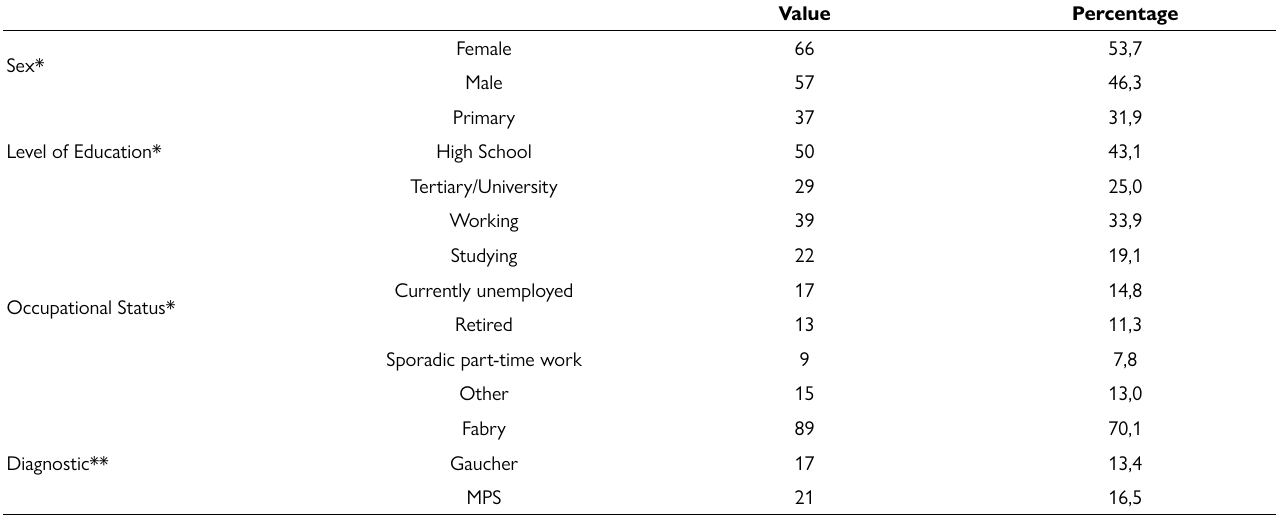
Table 1. Socio-demographic variables of the sample population